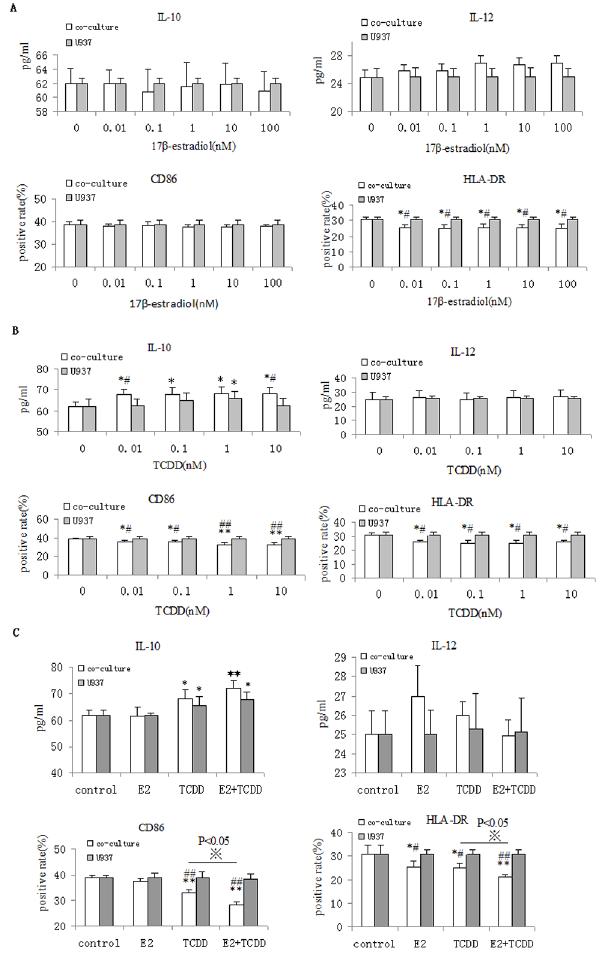
Fig 3. Combination of 17 β -estradiol and TCDD promotes M2 macrophage polarization by co-culture of ESC and U937. Co-cultured cells were treated with various concentrations of 17 β - estradiol (0.01 – 100nM) (A) or TCDD(0.1-10nM) (B), or 17 β -estradiol (1nM) plus TCDD 1nM) (C) for 48 hours, and then stimulated with LPS (10 ng/ml) for 24h. Finally, IL-10 and IL-12 secretion was measured by ELISA. Surface expression of CD86 and HLA-DR in U937 cells was determined by flow cytometry. Eutopic ESCs = ESCs from eutopic endometrium with endometriosis. Data are expressed as mean ± SD of independent experiment, performed in triplicate wells with three different samples. * P < 0.05, ** P < 0.01 compared with the vehicle control. #P < 0.05, ##P < 0.01compared with the U937 control. ※ P < 0.05 compared with the TCDD